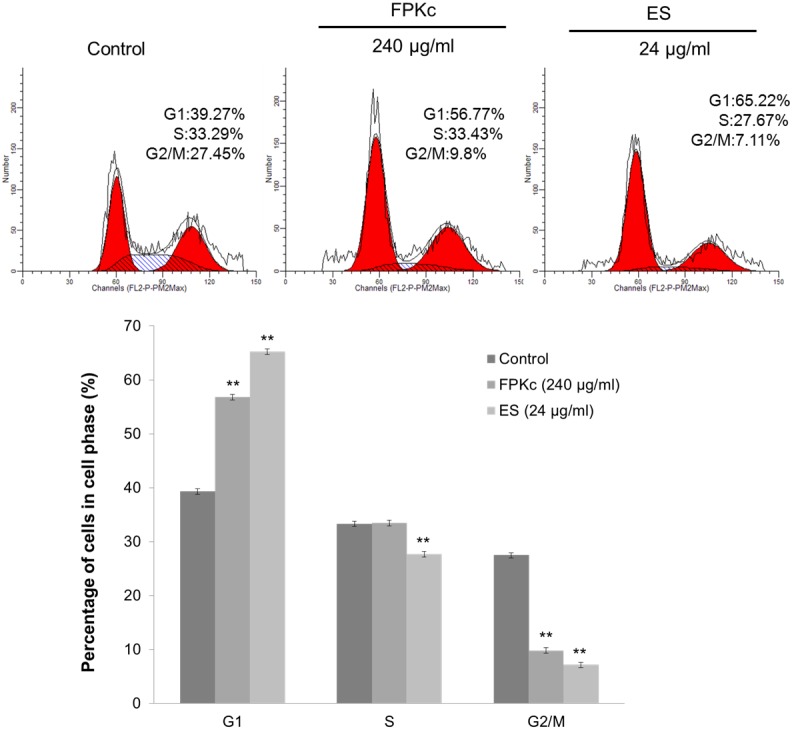
Cell cycle analysis of FPKc and ES-treated cells.SW-480 cells were harvested and fixed in 70% alcohol and then stained with PI. Finally the stained cells were analyzed using a flow cytometer.